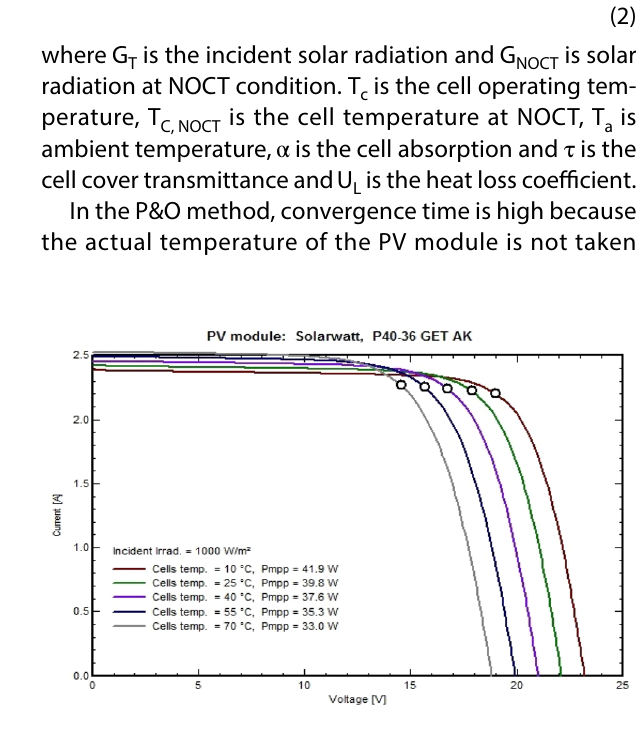
Fig. 1 PV module characteristics with